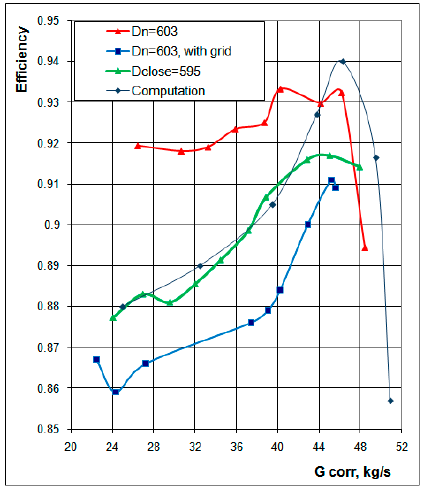
Figure 21. Fan adiabatic efficiency as a function of corrected air flow.